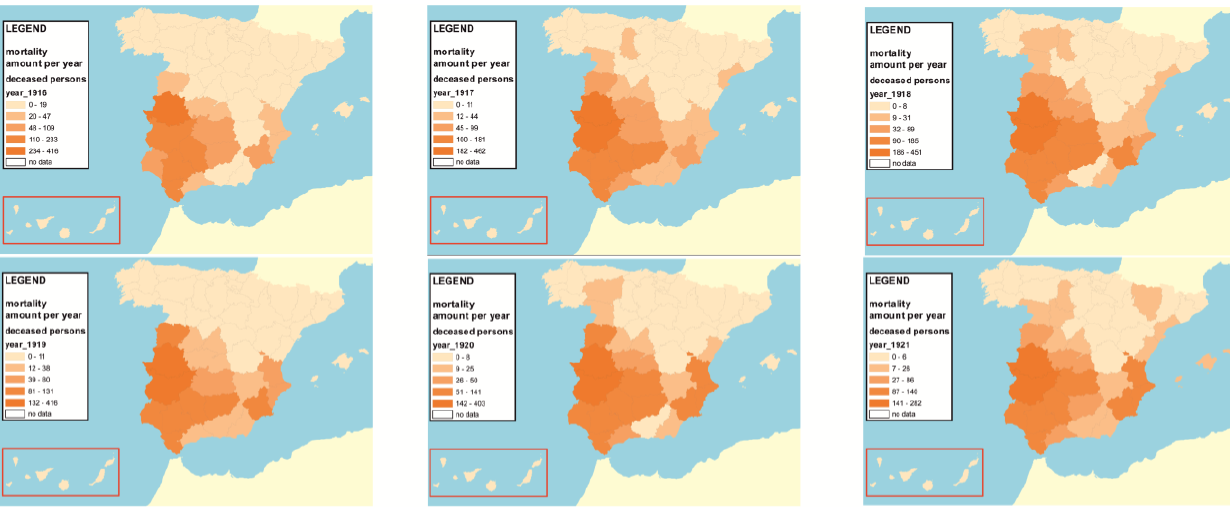
Figure A2. Maps of the distribution of the number of deaths people by malaria in each of the years (1916–1930) by